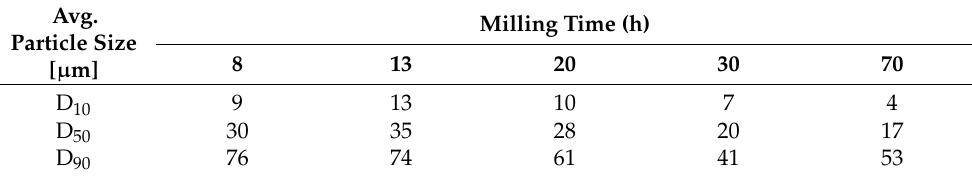
Figure 5. Granulometry graphs of Mg-Zn-Ca-Pr powders milled for ( a ) 8, ( b ) 13, ( c ) 20, ( d ) 30 and ( e ) 70 h, respectively. Featuring volume share (histogram) and cumulative volume (curve). Table 2. Average particle size for Mg-Zn-Ca-Pr alloy powders milled for a varied amount of time.